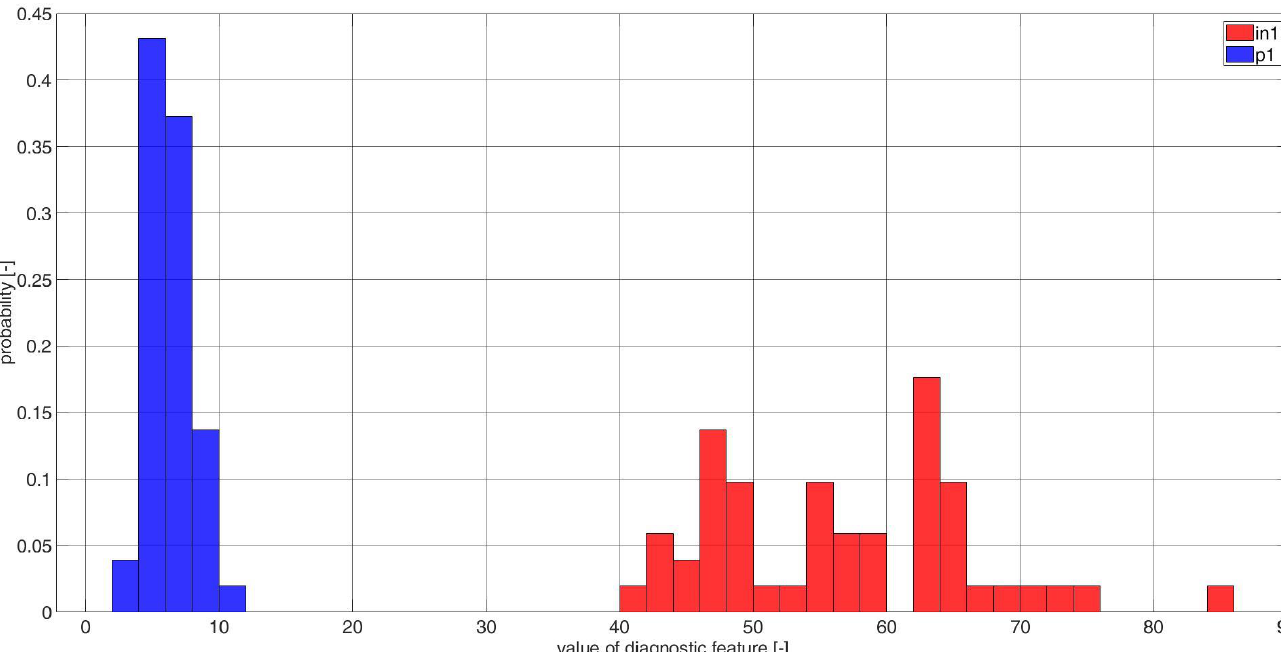
Figure A18. Histograms of diagnostic features based on the CCSM3 (correlation number is 20 — Table A1) bearings in2 and p2.